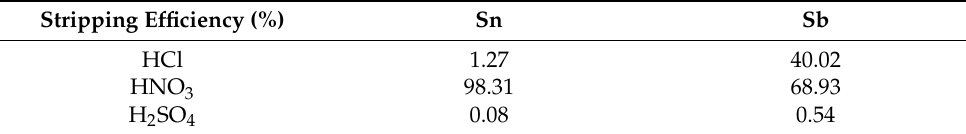
Table 4. Stripping efficiency of Sn and Sb with different 9 M stripping agents.